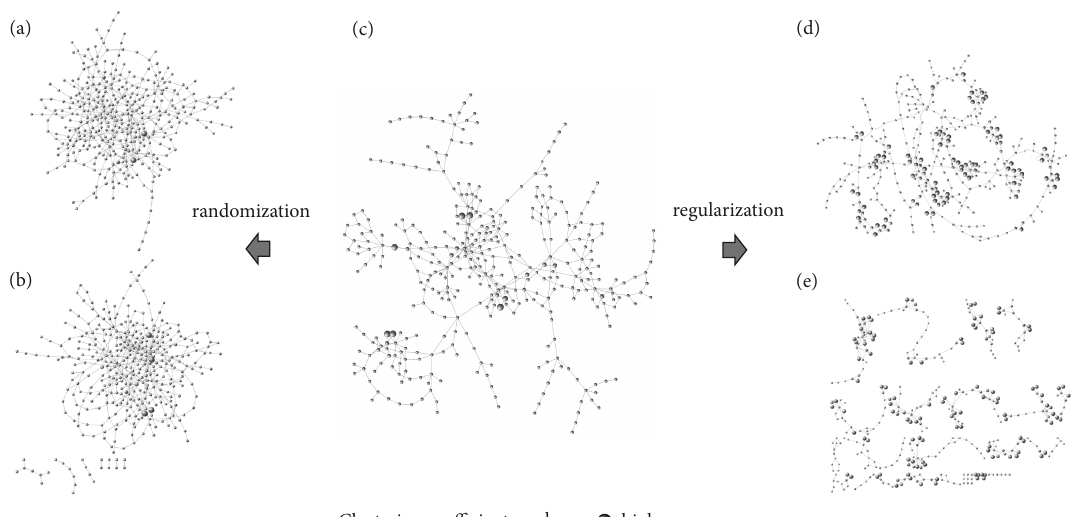
Figure 7: Creation of the equivalent random and regular lattice networks (same node degree distribution) by edge rewiring to test the small worldness. (a)-(b) Randomized networks with and without maintaining connectivity; (c) LLC of the dual mapped WDN 1910; (d)-(e) the lattice equivalents with and without maintaining